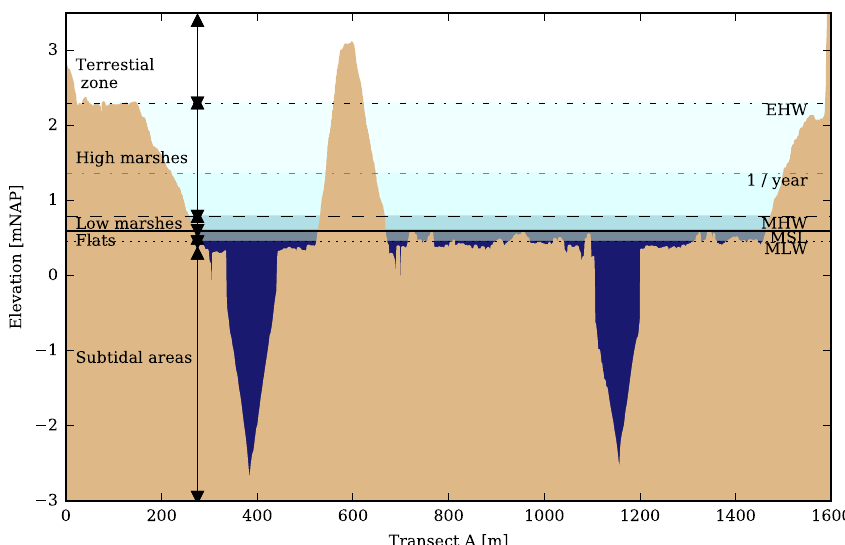
Figure 2. Elevation of Transect A (see Fig. 1) with respect to the Dutch Ordnance Datum (m NAP) with subdivision of the area into subtidal areas, flats, low and high marshes, and terrestrial zone relative to mean low water (MLW), mean sea level (MSL), mean high water (MHW), the maximum observed water level (EHW) and the water level for a peak discharge or storm with return period of 1 year, which were used to divide the study area